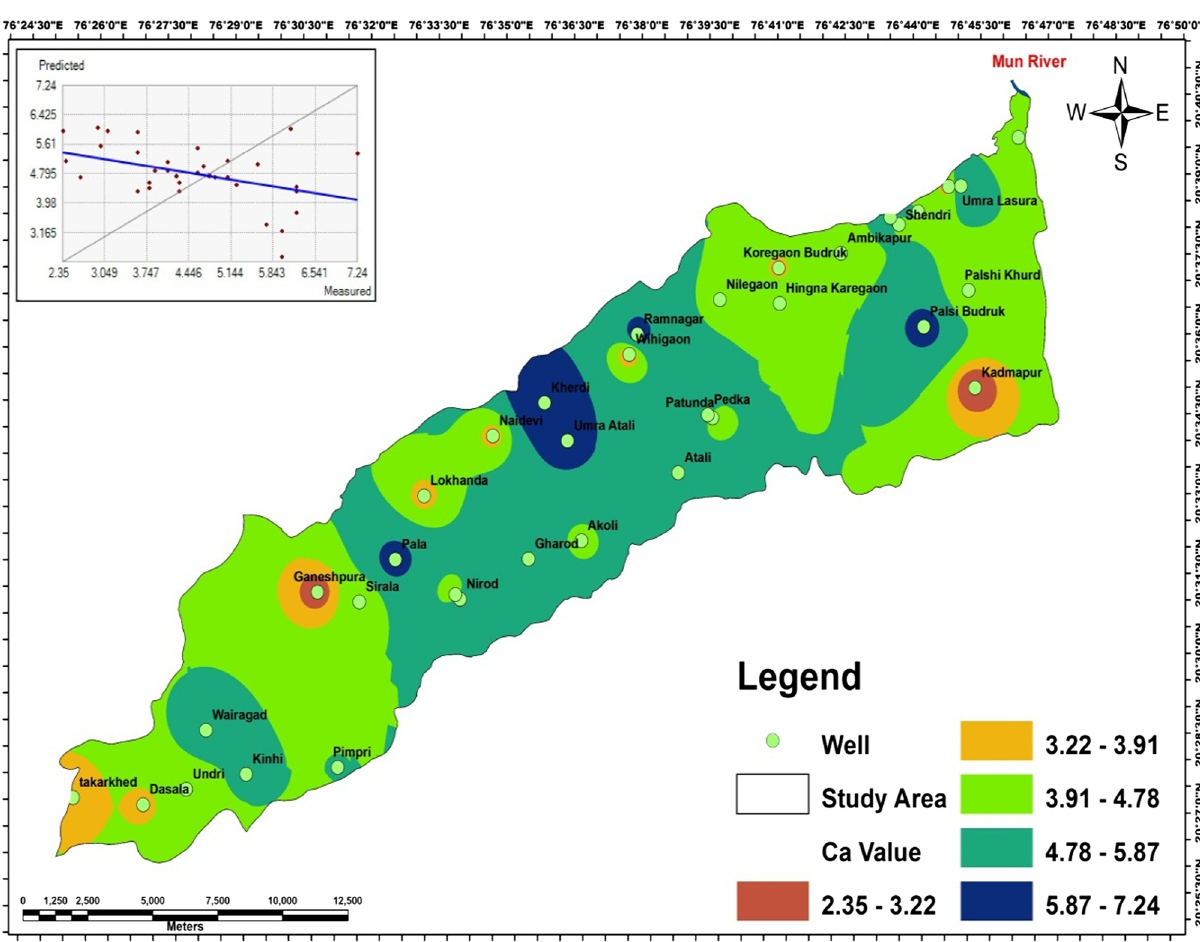
Fig. 7 Spatial distribution map of Ca post